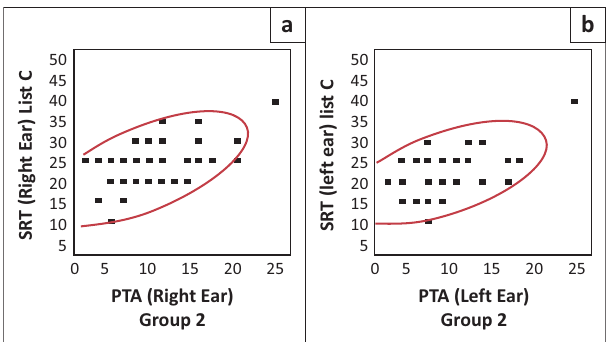
FIGURE 4: Pure-tone average/speech recognition threshold correlation for list C